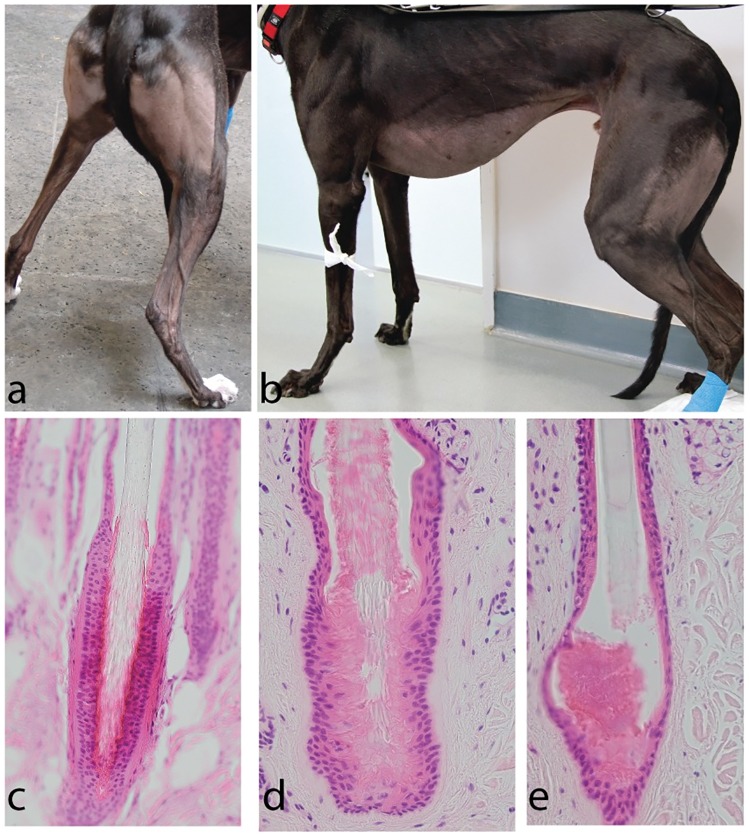
Clinical and histological phenotype of Greyhounds with BTS.(a) Affected dog with alopecia on the caudal and lateral thighs extending below the lateral hock area; (b) Affected dog with alopecia on the caudal and lateral thighs, the lateral hind leg down to the hock, the ventral abdomen and the ventral chest; (c) Normal telogen HF; (d) Telogen HF with an increased amount of trichilemmal keratin at the proximal end of the follicle. The more distal part of the HS is not anchored by trichilemmal keratin; (e) Horizontally broken telogen HF, which is not anchored by trichilemmal keratin and abundant keratin at the base of the follicle.